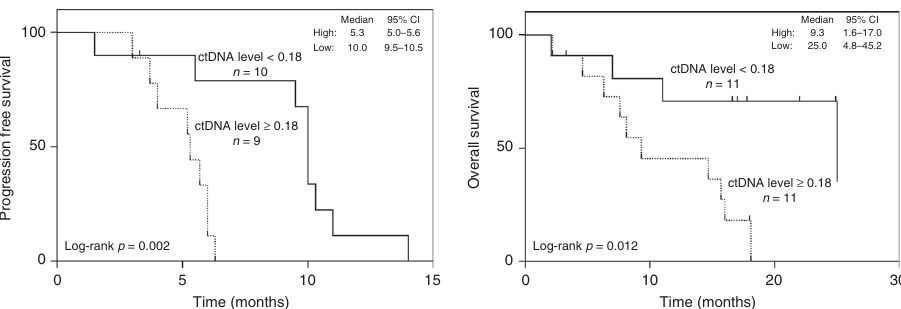
Fig. 4 The association of PFS and OS with ctDNA level measured by the average VAF of clonal mutations. Left, Patients were divided into two groups by ctDNA level. High ctDNA level group (higher than median of 0.18, dot line) was signi fi cantly associated with shorter PFS. Three patients were excluded from PFS analysis for three different reasons, including one patient who did not receive any treatment based on the patient's choice, one patient received surgery, and one could not offer out-patient otherapeutic records. Right, Patients were divided into two groups using the median ctDNA level of 0.18. Signi fi cantly shorter OS was observed in patients with higher ctDNA level (dot line). Small-cell lung cancer (SCLC) may evolve under treatment. But tumor tissues are often not available to study evolution of SCLC. Here, the authors utilize circulating tumor DNA to investigate the genomic evolution and subclonal architecture of SCLC